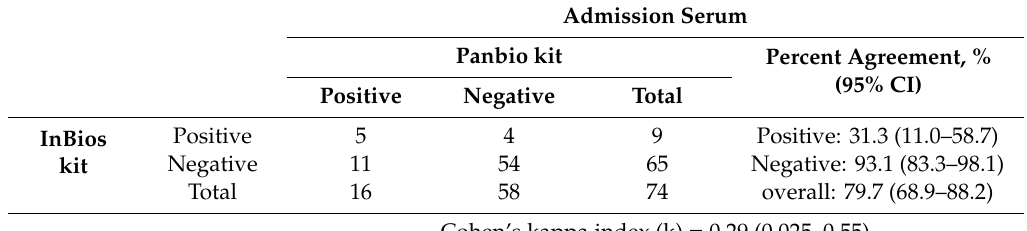
Table 4. Comparison of the Panbio and InBios kits results for dengue suspected patients, Panel